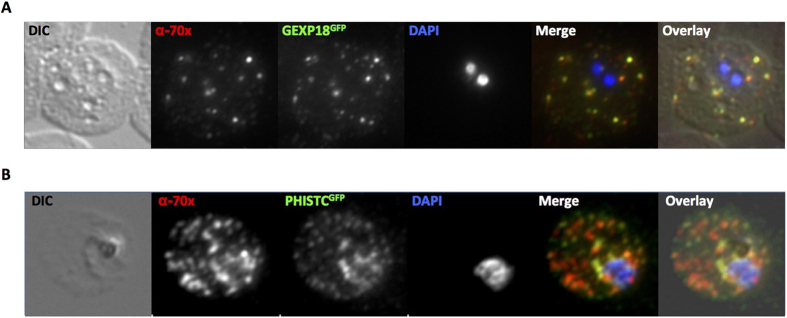
GEXP18 and PfPHIST_0801 are J-dot proteins.(A) Immunofluorescence using the J-dot marker PfHsp70x shows good colocalization with the GEXP18GFP chimera. (B) Immunofluorescence using the J-dot marker PfHsp70x shows good colocalization with PfPHIST_0801GFP. 70x, PfHsp70x; DIC, differential interference contrast, PHISTC, PfPHIST_0801.